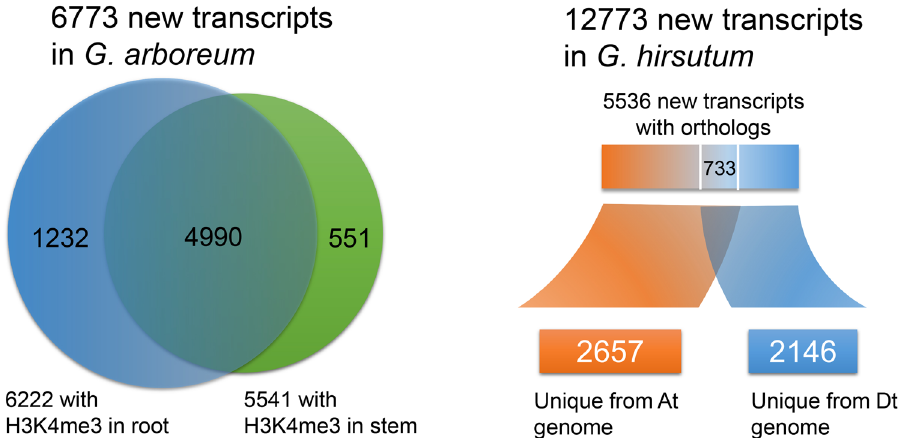
Figure 5. Detailed comparison for novel transcripts. ( A ) New transcripts, totalling 6,773, from G. arboreum derived from RNA-seq data, and new transcripts that have H3K4me3 evidence in root and stem. ( B ) The distribution of 5,536 new transcripts of G. hirsutum with orthologues in donor genomes. 2,657 transcripts only have an orthologue in the At genome donor ( G. arboreum ) and 2,146 transcripts only have an orthologue in the Dt genome donor ( G. raimondii ).